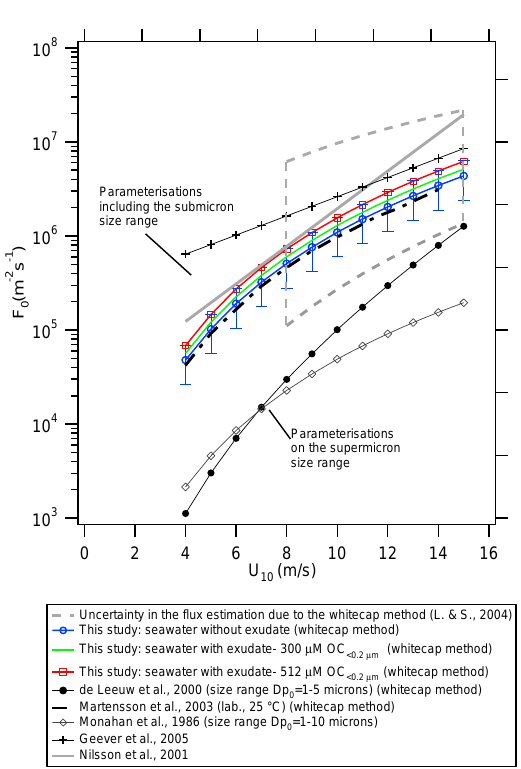
Fig. 15. Comparison of total source flux derived in this study as a function of the wind speed for organics-free seawater and seawater enriched with organic matter and other available parameterisations defined in the submicron and supermicron size regions in the liter- ature. Error bars are included for indication of the upper and lower bounds in the particle flux determination as a result of propagation of errors through the analysis